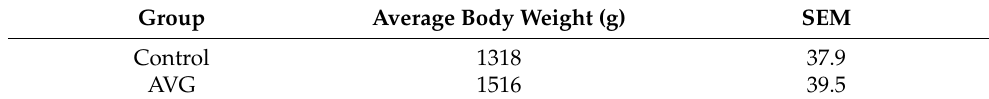
Table 1. Average body weight of the birds on day 28 (Sample collection day).